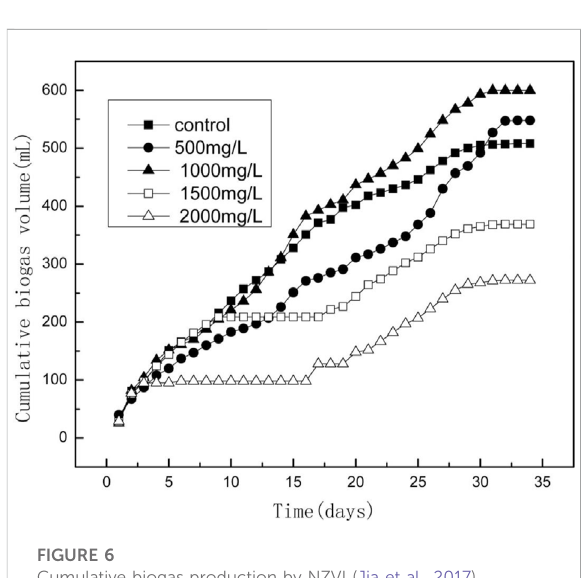
FIGURE 6 Cumulative biogas production by NZVI (Jia et al.,